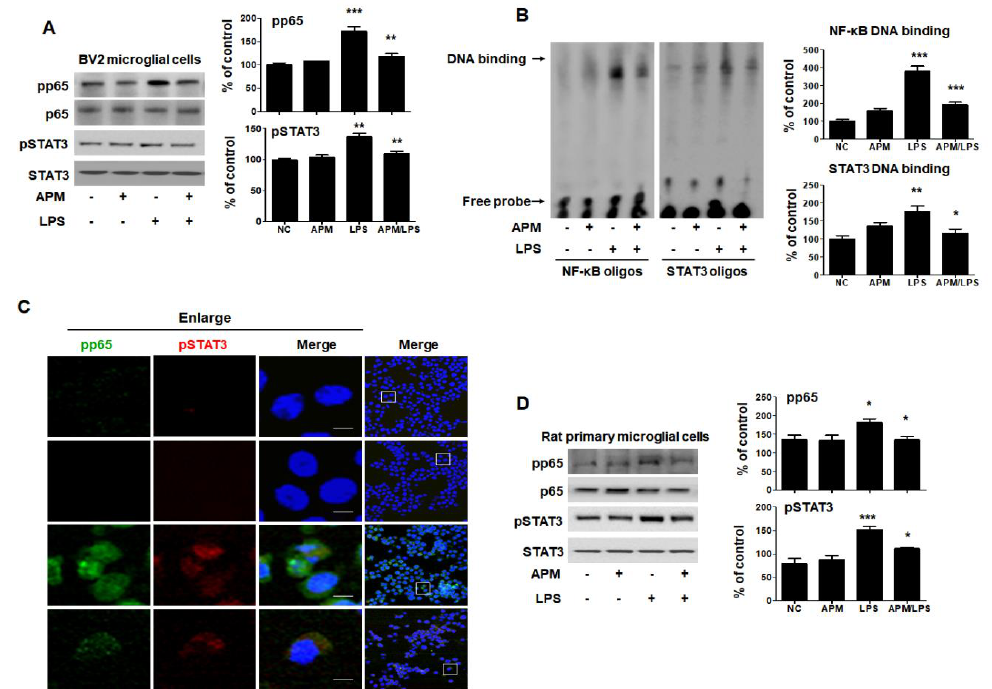
Figure 4. APM suppresses translocation of p65 and STAT3 in LPS-stimulated BV2 and rat primary microglial cells. Cells were treated with APM for 1 h followed by LPS for 6 h. Expression of pp65 and pSTAT3 in nuclear extracts was measured by immunoblotting in BV2 and rat primary microglial cells. APM significantly reduced LPS-induced phosphorylation of p65 and pSTAT3 in BV2 ( A ) and rat primary microglial cells ( D ). DNA-binding activity of NF- κ B and STAT3 in nuclear extracts was measured by electrophoretic mobility shift analysis (EMSA) in BV2 microglial cells ( B ). EMSA was quantified by densitometric analysis. Immunofluorescence double staining for pp65 (green) and pSTAT3 (red) localization ( C ) in BV2 microglial cells. Cell were counterstained with DAPI (blue). Magnification 400 × . Enlarge figure of scale bars: 5 µ m. β Actin was used to confirm equal sample loading. pp65 and pSTAT3 followed by densitometric analysis. The data are representative of three independent experiments and quantified as mean values ± SEM. Tukey’s multiple comparison test, * p < 0.05, ** p < 0.01, *** p < 0.001 compared to normal